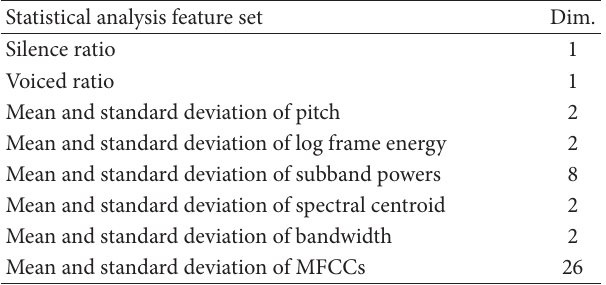
Table 2: Adopted statistical analysis features after feature